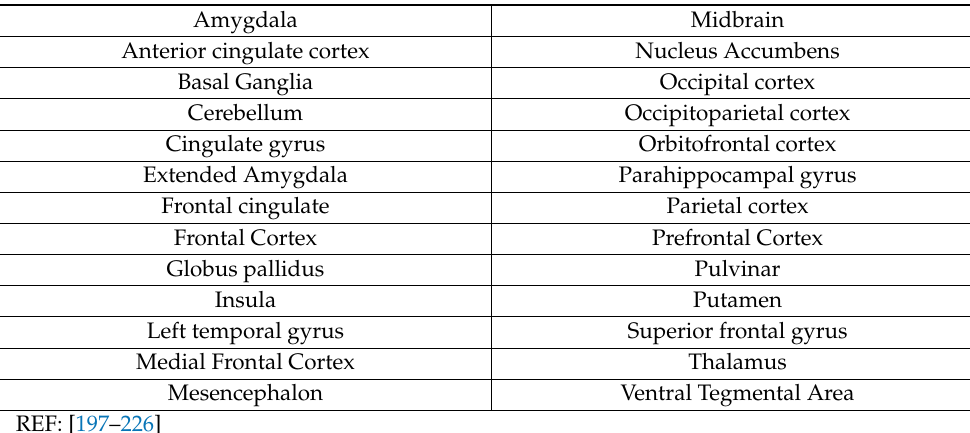
Table 4. Common areas of brain atrophy in SUD and MCI. Amygdala Midbrain Anterior cingulate cortex Nucleus Accumbens Basal Ganglia Occipital cortex